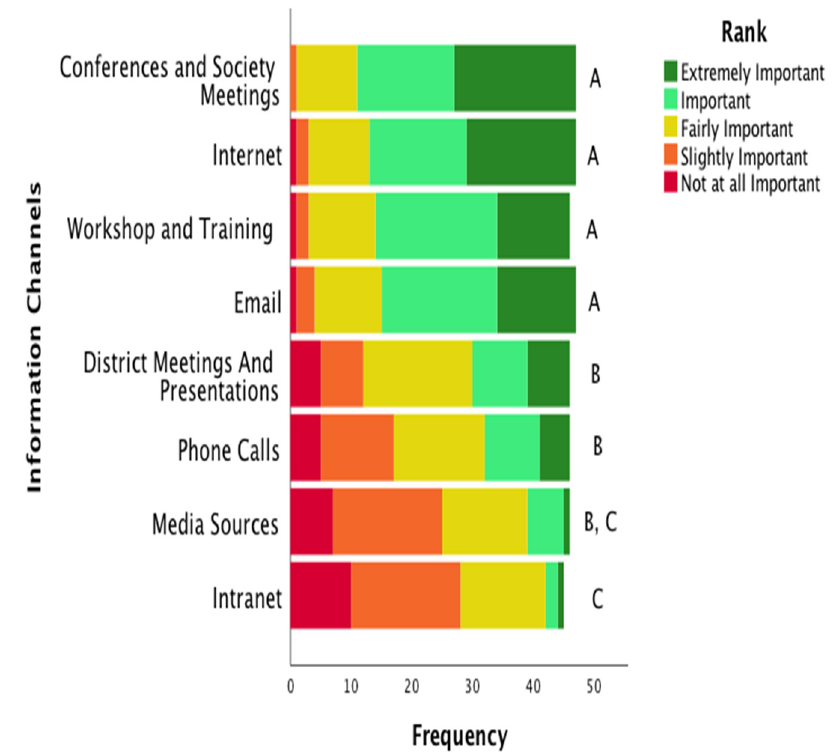
Figure 2. Specialists’ Information Channels. These data are reported in a frequency format with color-coded stacked bars representing the frequency of the sample that valued each information channel. Information channels are listed in order of significance. Lettering at the end of the bars were indicates statistical differences between each channel. That is, each letter indicates the presence of a statistically significant difference between that channel and any differently lettered channel. Identical lettering indicates that there is no statistical difference ( p > 0.05) between channels.